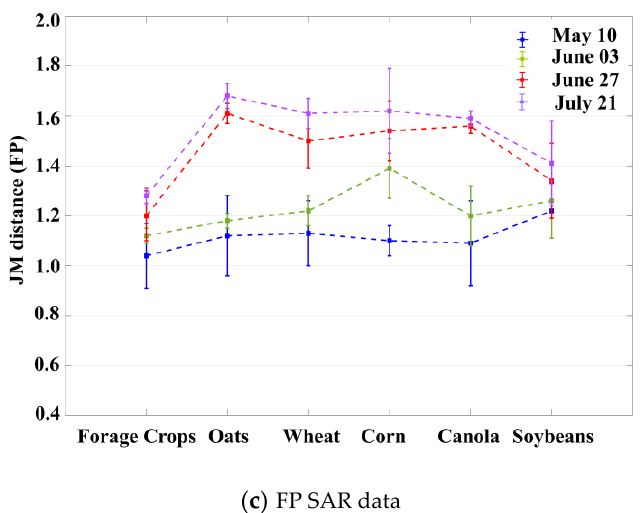
Figure 2. Mean JM distances for each crop to the others using intensity features extracted from ( a ) DP, ( b ) CP, and ( c ) FP SAR data.